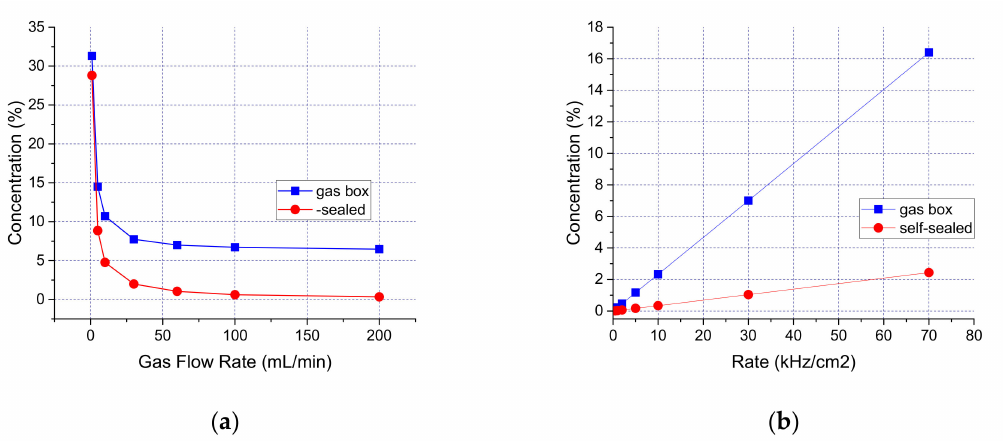
Figure 1. The flow scan and rate scan results: ( a ) the flow scan of two models, at a fixed rate of 30 kHz/cm 2 ; ( b ) the rate scan of two models, at a fixed gas flow of 60 mL/min. The simulation has been through iterations to a high precision, so the error bars are contained within the symbols.